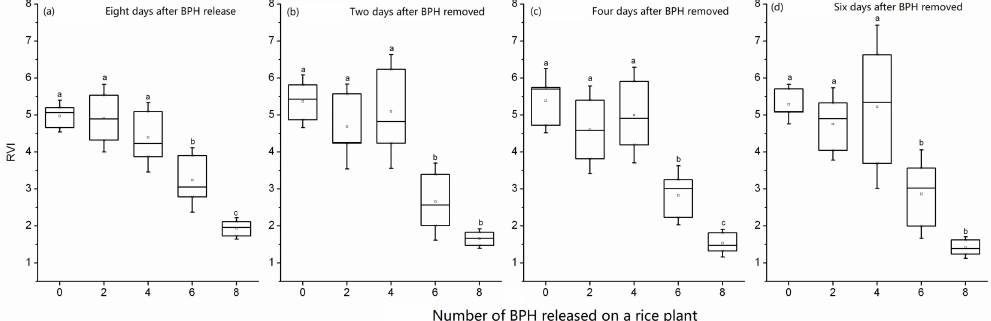
Figure 6. RVI 746/670 of rice leaves exposed to 0–8 second-instar BPH nymphs for eight days ( a ) and 2–6 days after BPH exposure ( b , c , d ). In the box plot, the box represents the 25th and 75th percentiles; whiskers represent the minimum and maximum values; the line in box represents the median percentile; the open circle in a box represents the mean. The different letters above the box plots show significant differences in the RVI 746/670 means among different numbers of BPH at p = 0.05